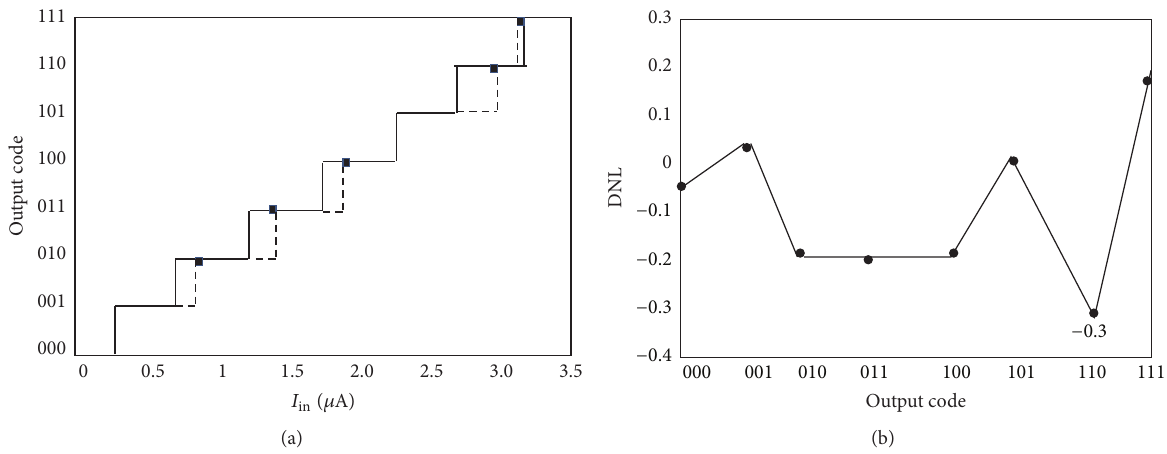
Figure 16: (a) Transfer characteristics of two-step flash ADC using proposed comparator and (b) DNL versus output code.